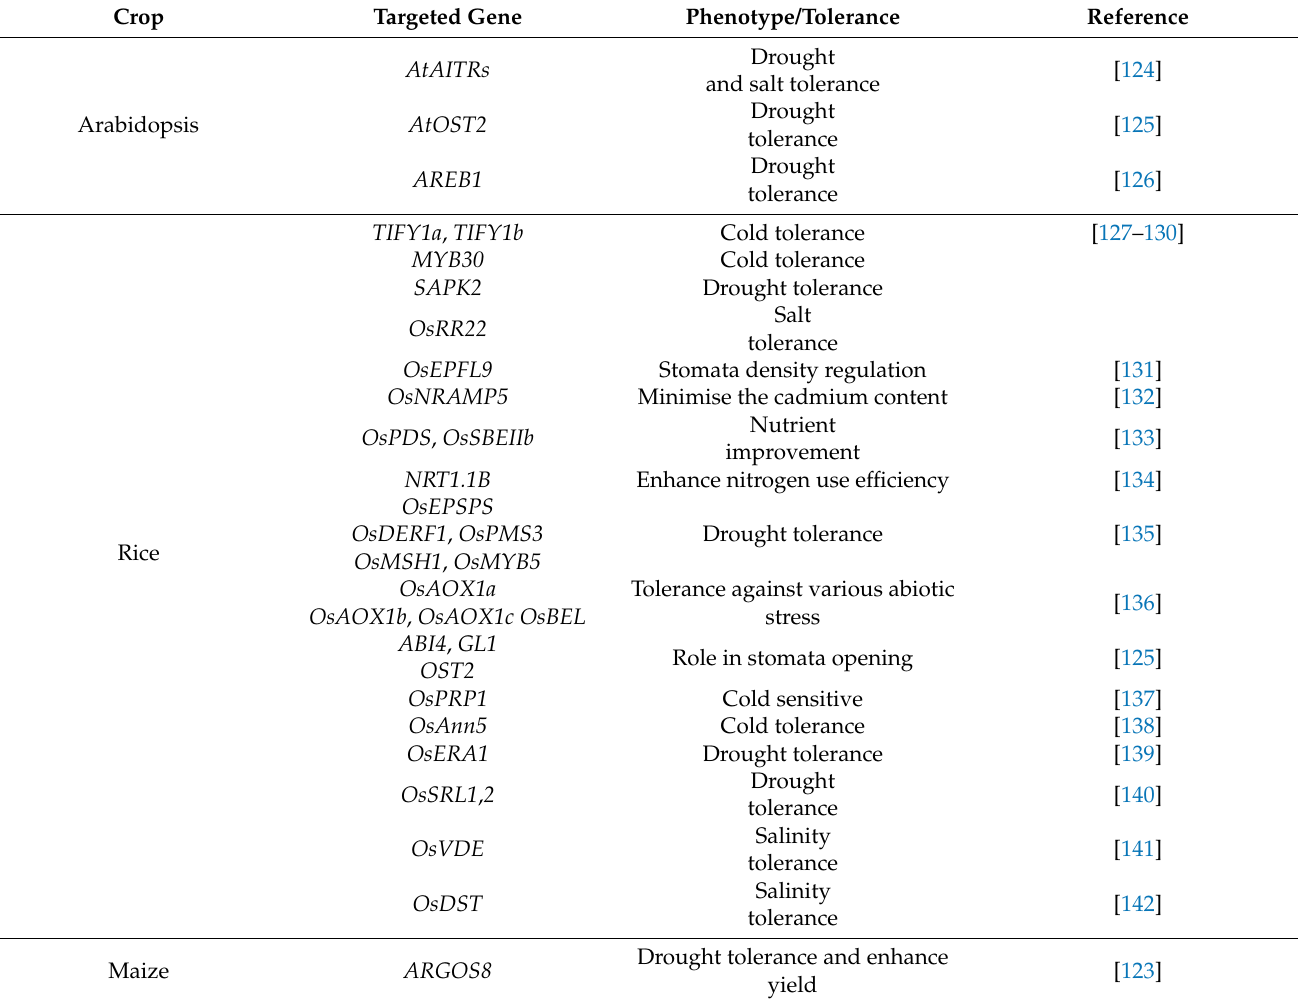
Table 2. Some of genes targeted by CRISPR/Cas9 tool and their application in abiotic stress tolerance. Crop Targeted